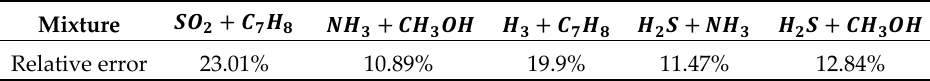
Table 1. Binary mixture reconstruction error.